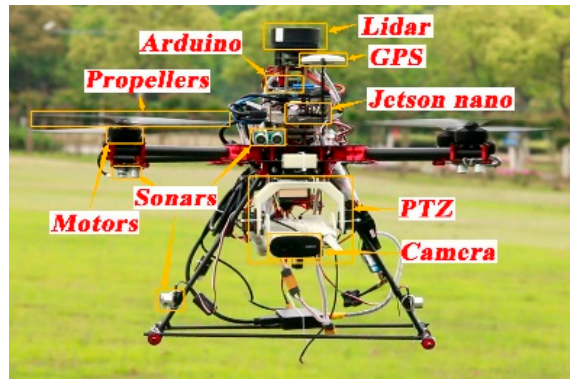
Figure 2. Photo of prototype.